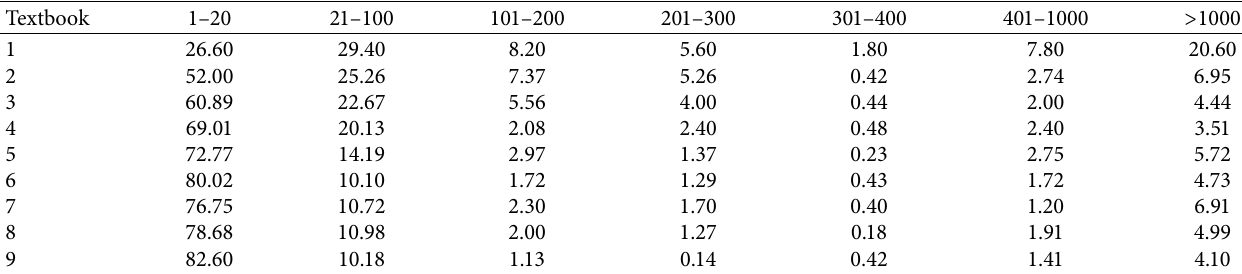
Table 5: Distribution of sentence semantic universality in each textbook (Method